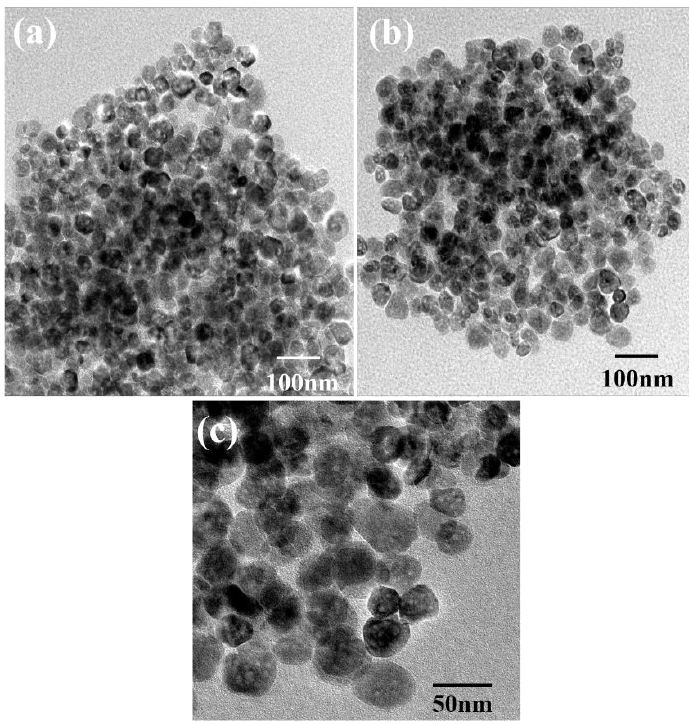
Figure 3. TEM images of the Fe 3 O 4 nanoparticles at ( a ) 100 nm; ( b ) 100 nm and ( c ) 50 nm magnifications.